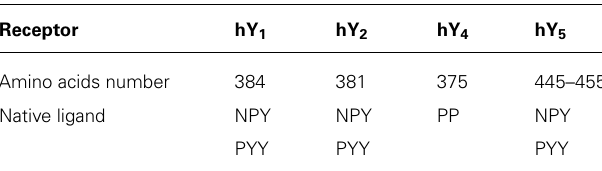
Table 2 | NPYR: sequence length and ligand